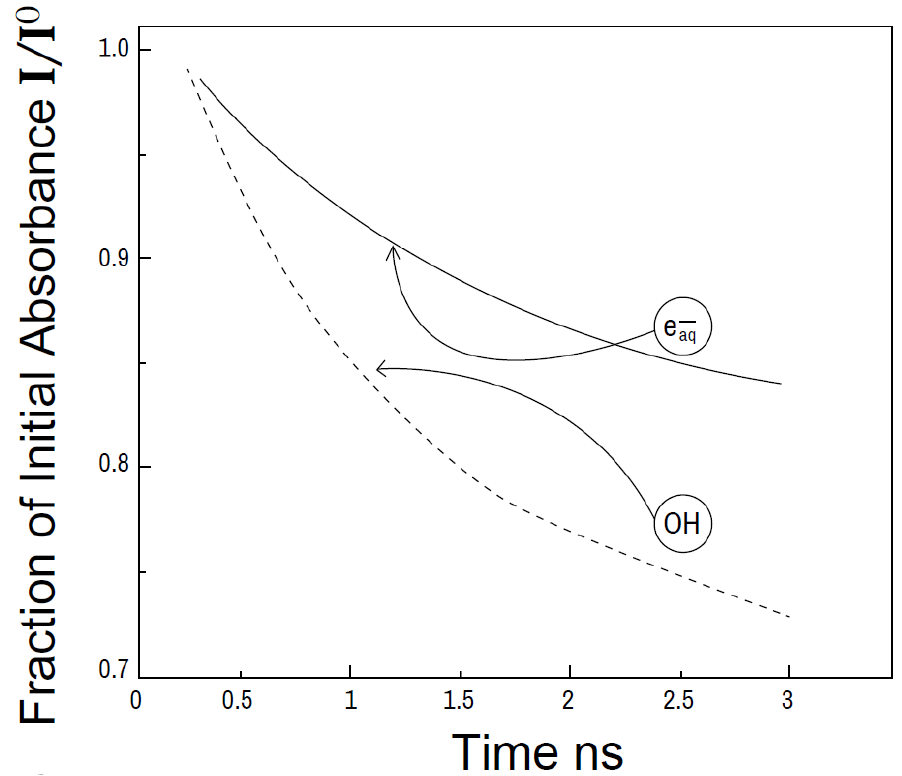
Figure 12. Decay of the concentrations of aquated electrons ( e aq− ) and OH radical generated by a 30 ps pulse of 20 MeV electrons in liquid water. Adapted from [67].